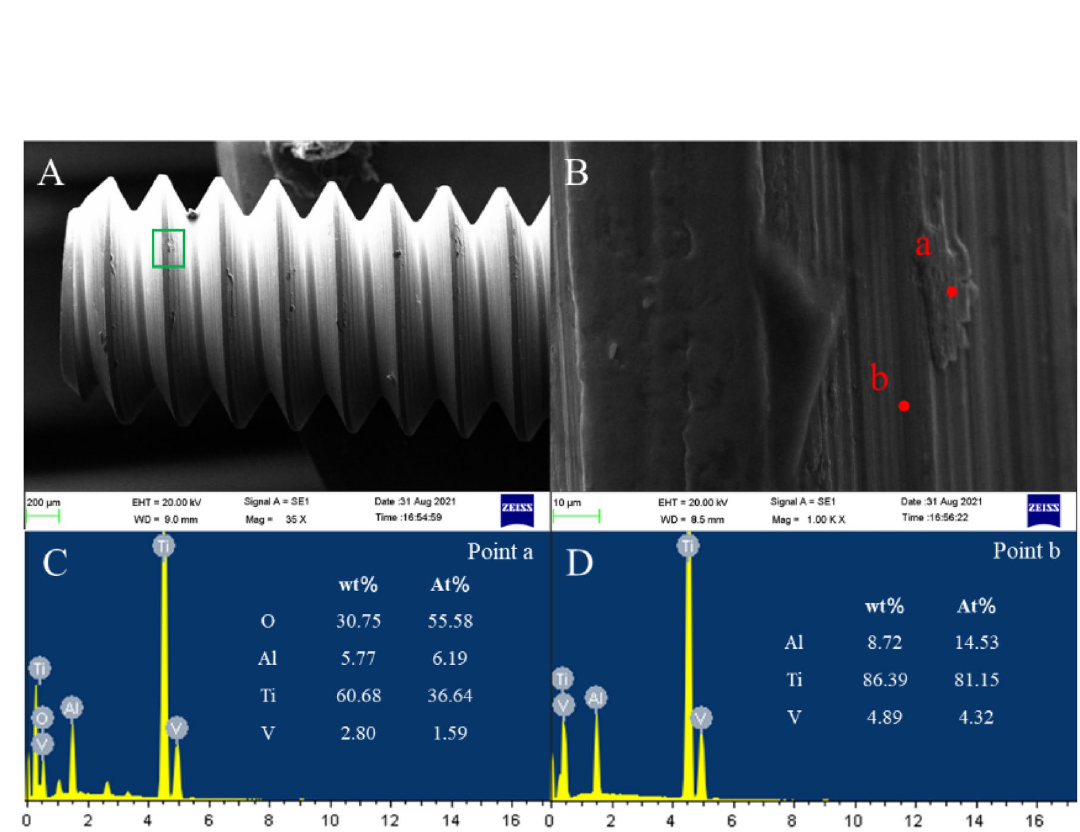
Figure 7. Screw surface wear in the SC group. ( A ) Screw morphology, ( B ) area shown in ( A ), ( C ) EDS at point (a), and ( D ) EDS at point